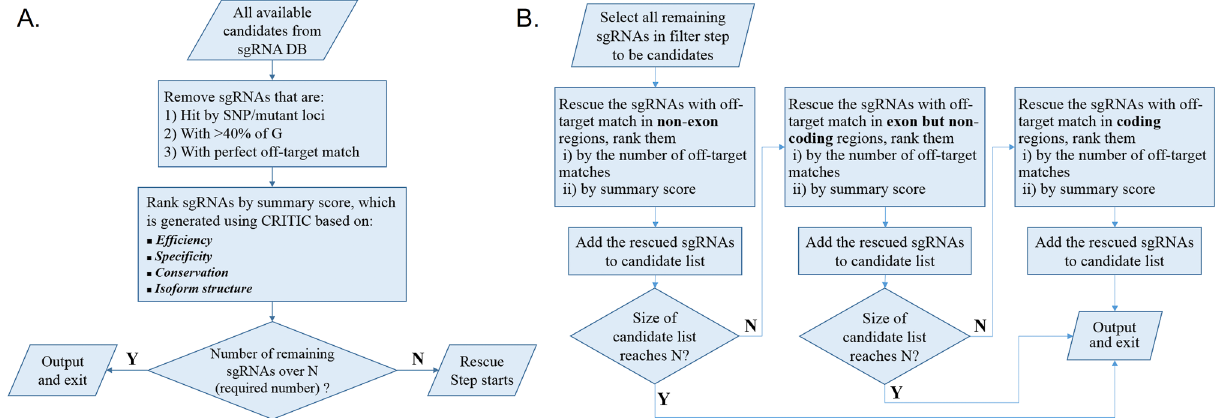
Fig 2. Workflow of the sgRNA selection/ranking process in CRISPR-FOCUS. The sgRNA selection/ranking process in CRISPR-FOCUS is composedof (A) a filter step and (B) a rescue step.